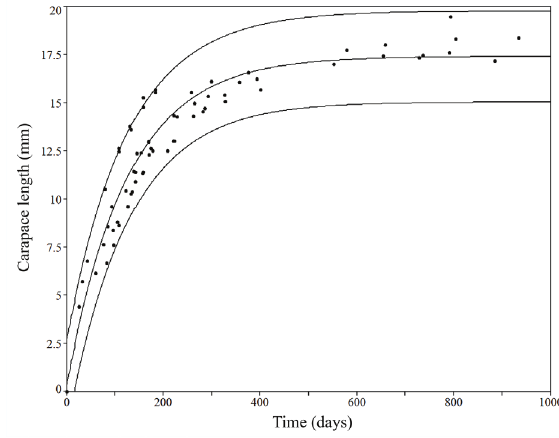
Figure 6 - Rimapenaeus constrictus . Mean estimated growth curve based on the von Bertalanffy growth model for females sampled from July 1998 to June 2003 in the Ubatuba region, northern São Paulo state. Outer lines: 95% prediction intervals.